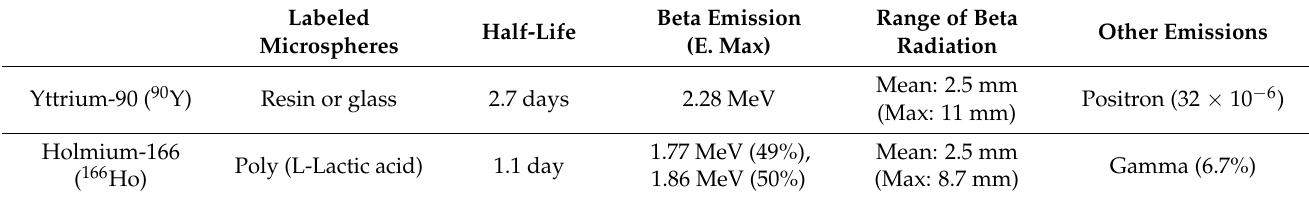
Table 1. Physical characteristics of radionuclides.